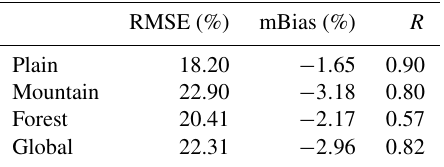
Table 4. Summary of accuracies of AVHRR raw snow data with Landsat5 TM snow data over the whole HKH region.